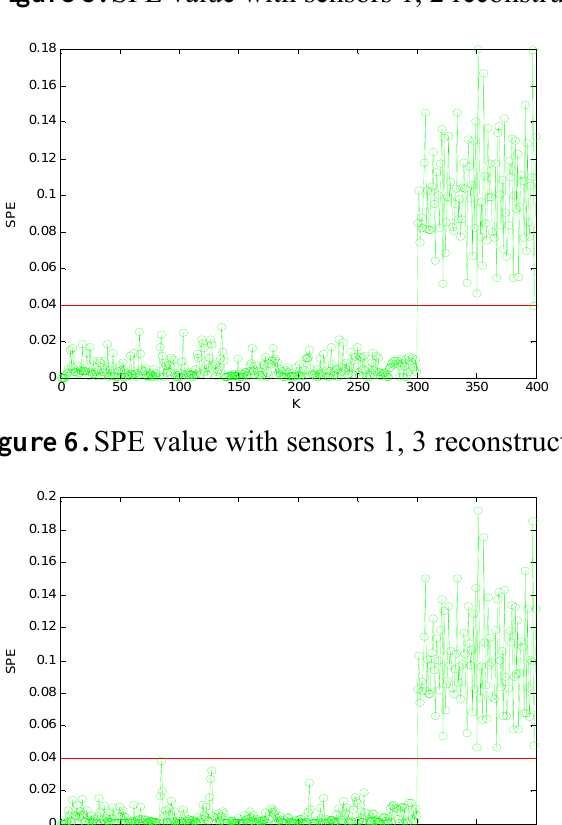
Figure 5. SPE value with sensors 1, 2 reconstructed.